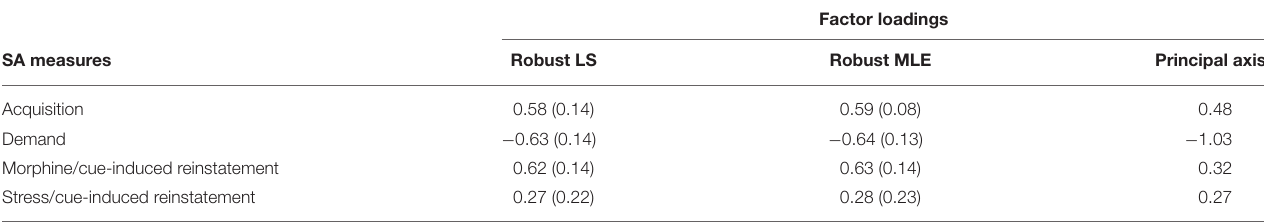
TABLE 1 | Estimates for factor loadings from 3 analyses, with bootstrapped standard errors for the factor loadings from the two robust methods in parenthesis.